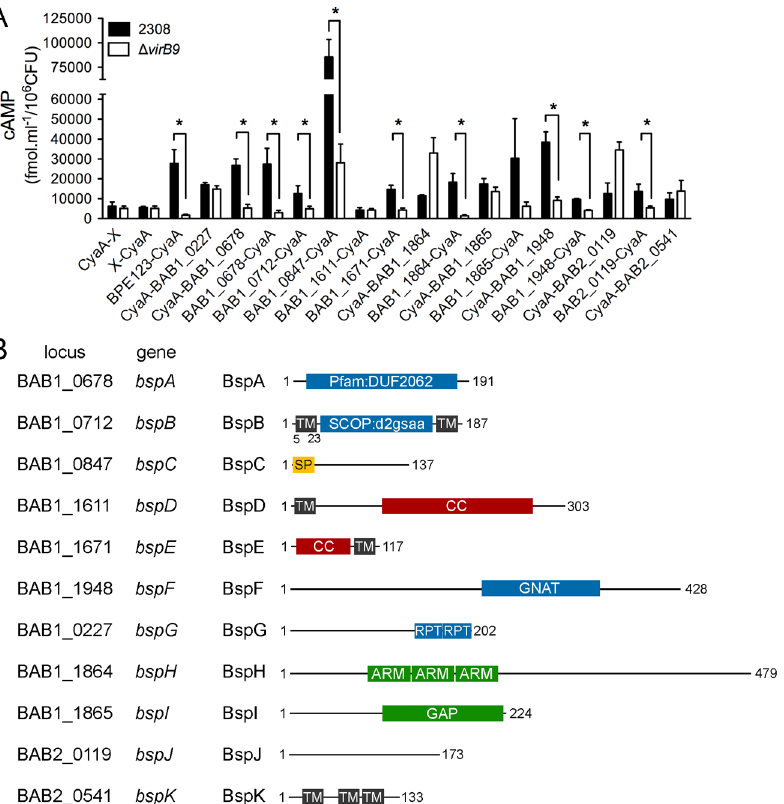
Figure 2. VirB-dependent translocation of Brucella Bsp effectors into J774.A1 cells. (A) B. abortus strain 2308 (black bars) or the D virB9 mutant strain (white bars) expressing the CyaA fusions to the indicated Brucella proteins were used to infect J774.A1 cells, and the cAMP level of infected cells was determined. A previously identified VirB effector, BPE123, was used as a positive control while vectors expressing the CyaA domain alone (CyaA-X or X-CyaA) were used as a negative control. Total cAMP levels resulting from translocation of protein fusions were quantified and are expressed as fmol.ml 2 1 /10 6 CFUs. Results are means 6 SD from a representative experiment performed in triplicate. (B) Schematic representation of Brucella secreted proteins (Bsp proteins), indicating the corresponding locus, protein lengths and predicted domains or